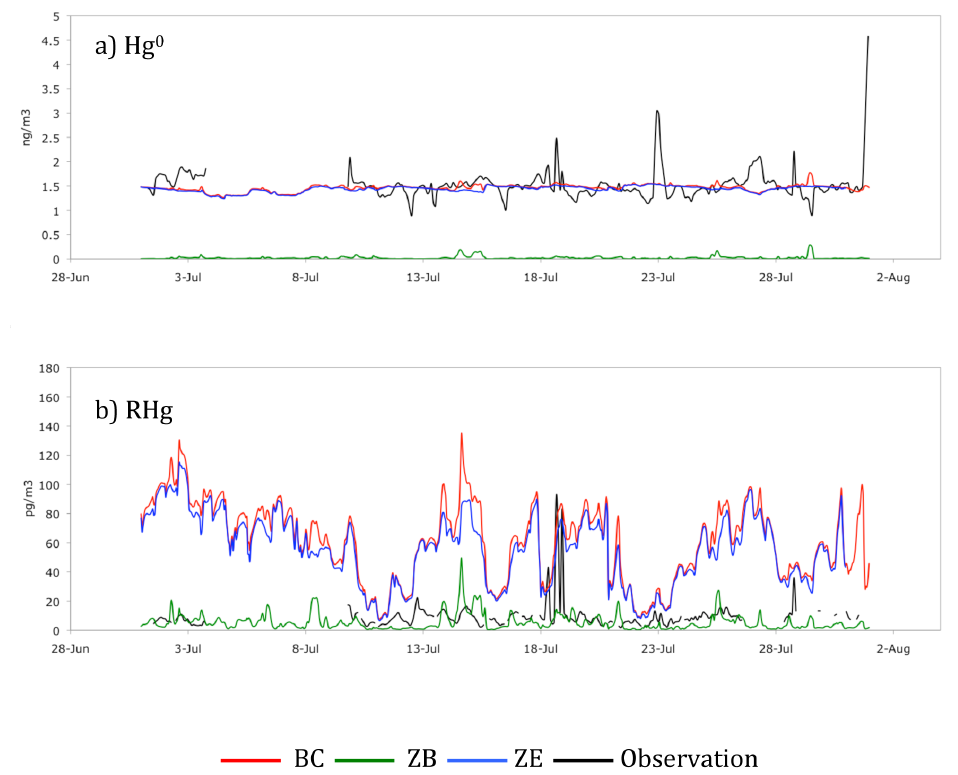
Fig. 5. Comparison of July 2003 CMAQ-Hg simulated ambient mercury species at DL in the base case (BC), zero boundary inflow (ZB), and zero emissions (ZE) cases against observed values for Hg 0 ( a , units ngm − 3 ) and RHg ( b , units pgm − 3 )